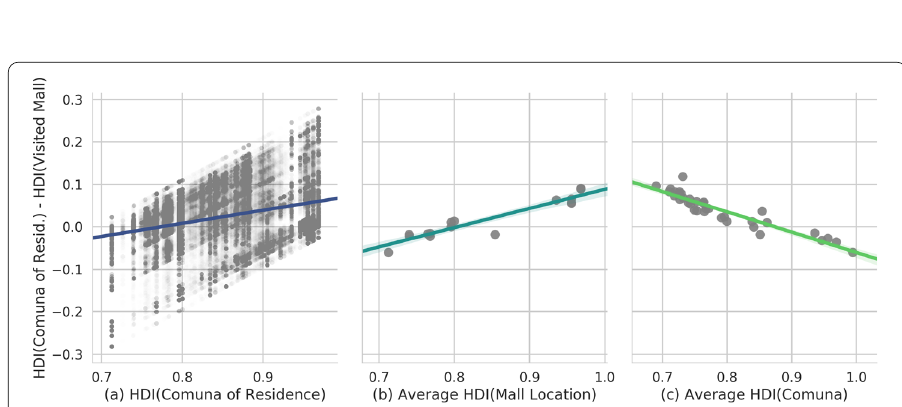
Figure 5 Correlations of HDI: ( a ) comuna of residence, and the difference between HDI of the comunas of visited malls; ( b ) Mall HDI (based on mall location), and the average differences between visited mall HDI and HDI of user’s residence; ( c ) HDI Average HDI of each comuna ’s inhabitants, and the difference with the HDI of their visited malls